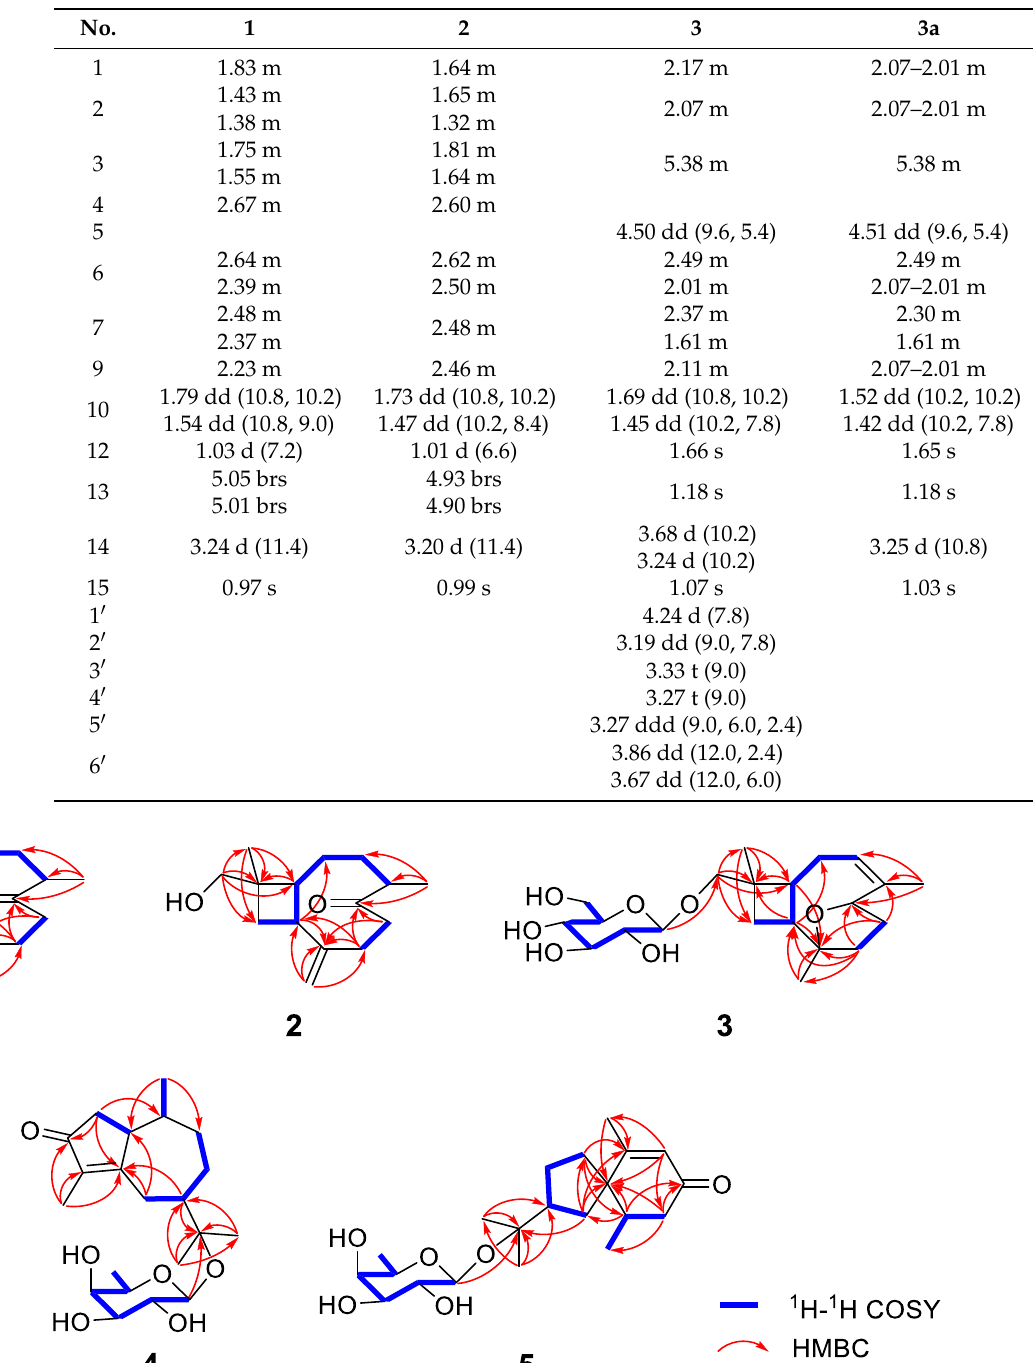
Table 1. 1 H NMR data of compounds 1 – 3 and 3a in CD 3 OD ( δ in ppm, J in Hz).